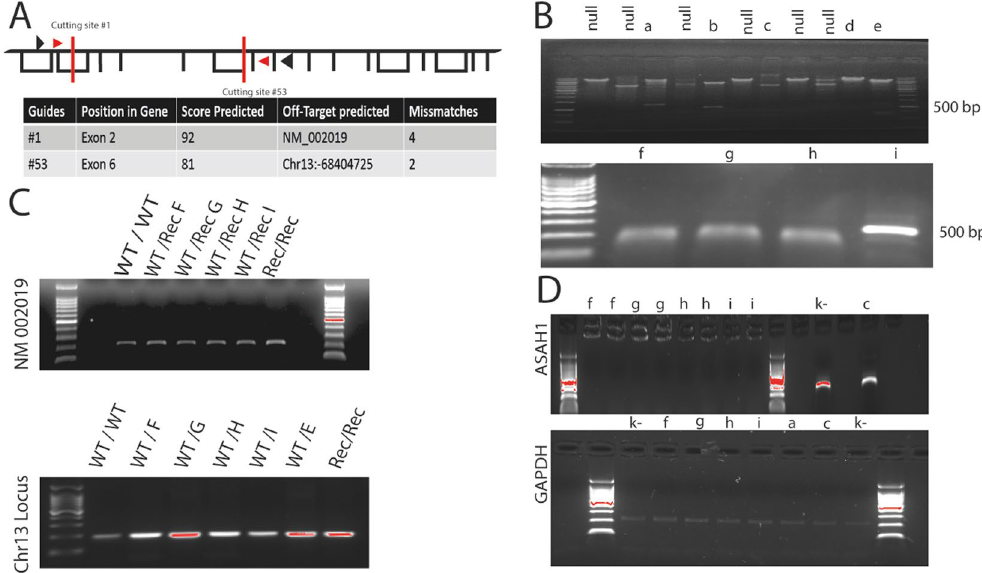
Figure 1. Deletion of the ASAH1 gene in A375 melanoma cells. ( A ) Schematic structure of the ASAH1 gene. Red bars indicate gRNA recognition sites, arrows indicate the annealing of nested PCR primers. Predicted guide score and possible off-target sites are also shown. ( B ) Nested PCR analysis of the ASAH1 gene showing events ofdeletion in heterozygosis ( a, b, c, e ), in homozygosis ( f, g, h, i ). ( C ) Surveyor Nuclease Assay on two loci indicated in panel ( A ) demonstrating the lack of detectable off-target activities of the guides utilized in the present study. ( D ) RT-PCR analysis shows lack of ASAH1 transcription in deleted clones. ASAH1 transcripts are still present in clones with single insertion/deletion (InDel) mutations